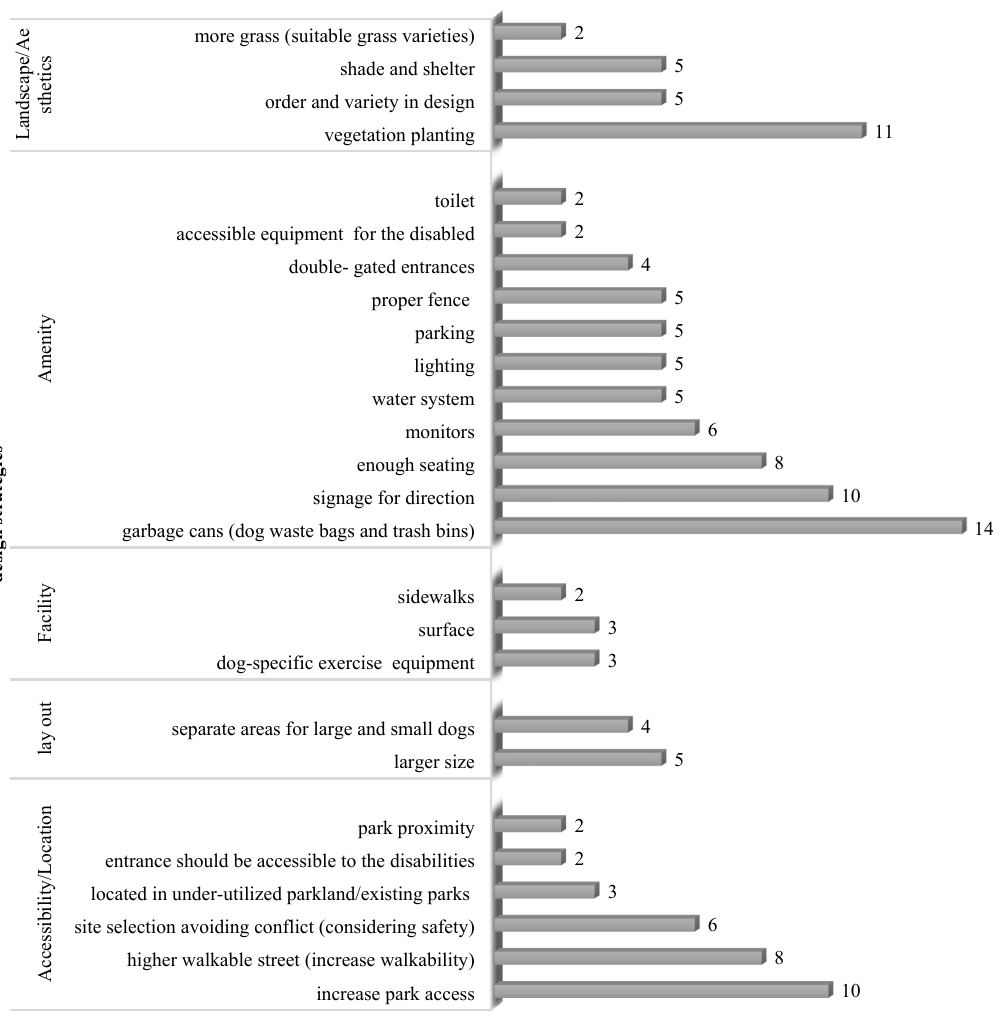
Figure 6. Count of studies summarizing the design strategies for dog park.